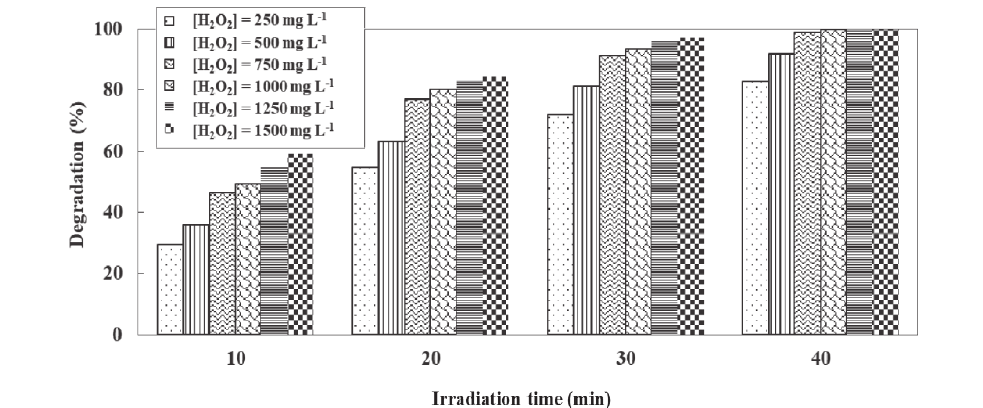
Fig. 4 – Effect of the initial concentration of H O on the removal percent of PNP in the SDP. [PNP] = 20 mg L –1 , volume = 500 2 2 mL, pH = 5.5, rotation speed = 300 rpm, light intensity = 33 W m –2 , distance between lamps= 3.5 cm.